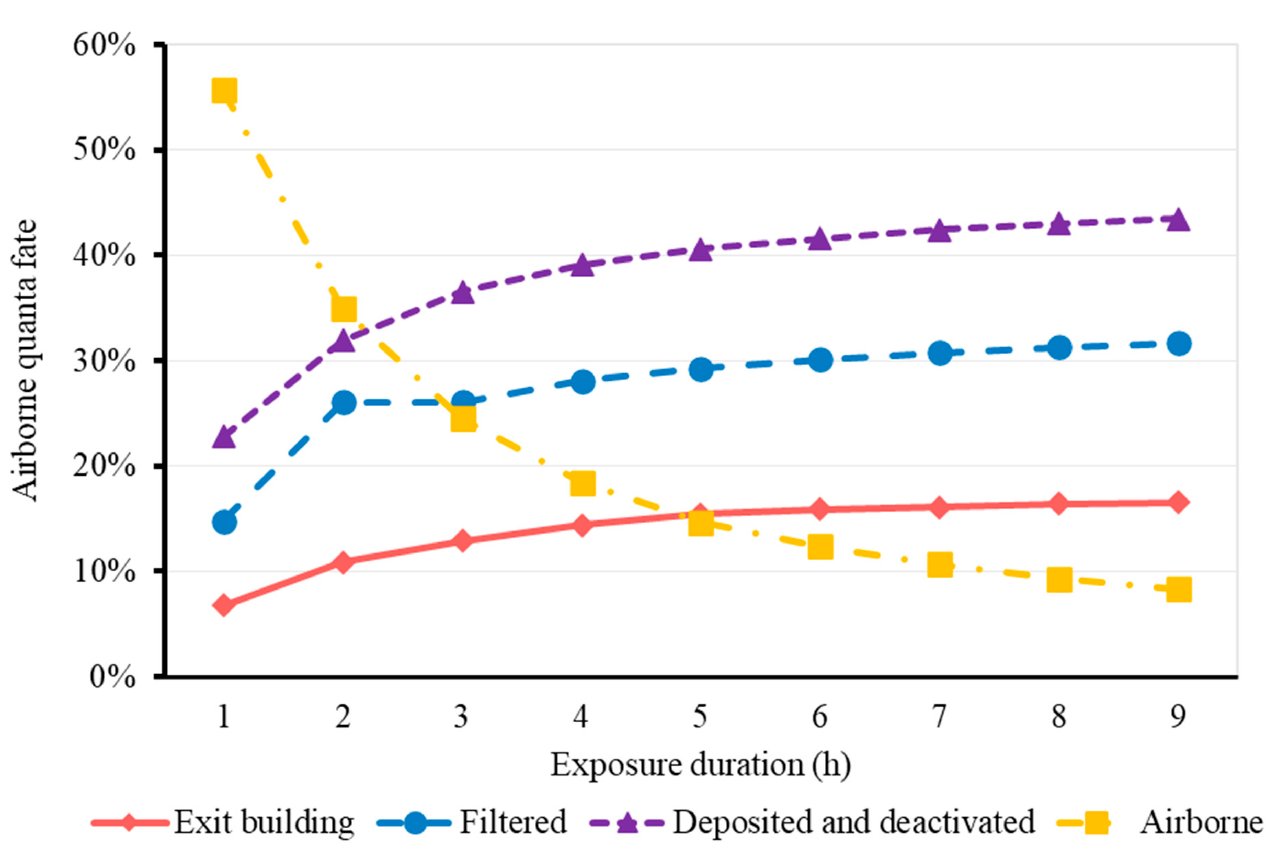
Figure 10. The fate of airborne quanta in Medium Office (Baseline case) versus exposure duration.